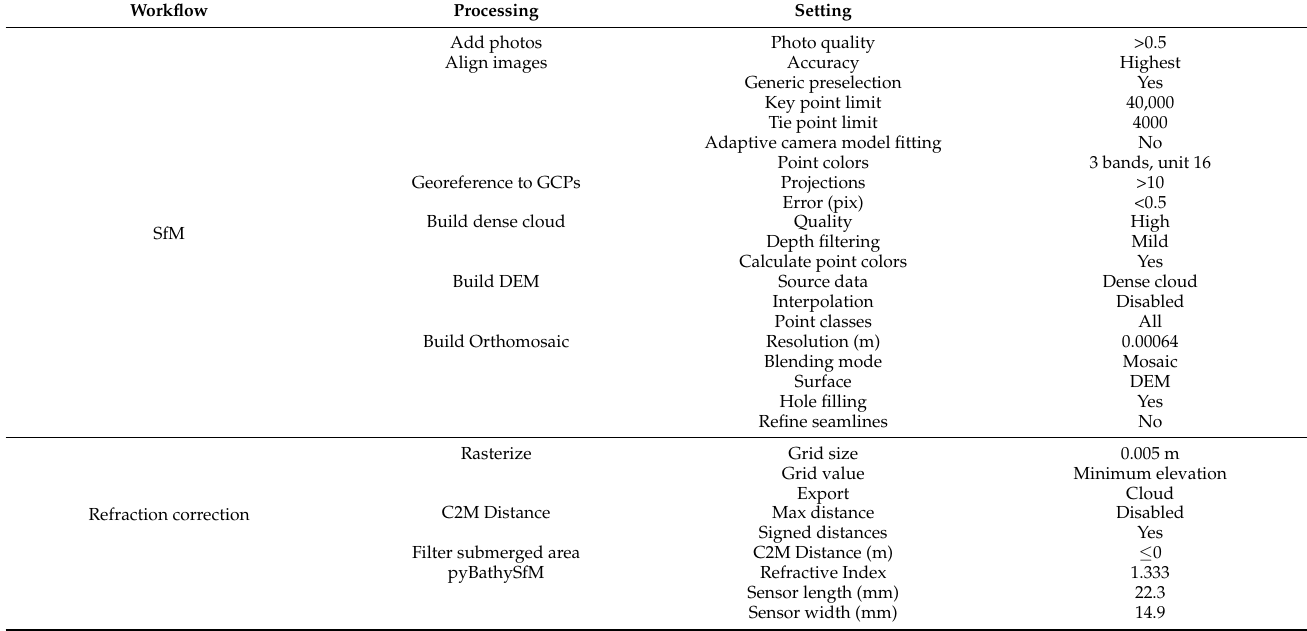
Table A1. Settings for the Structure-from-Motion (SfM) and refraction correction